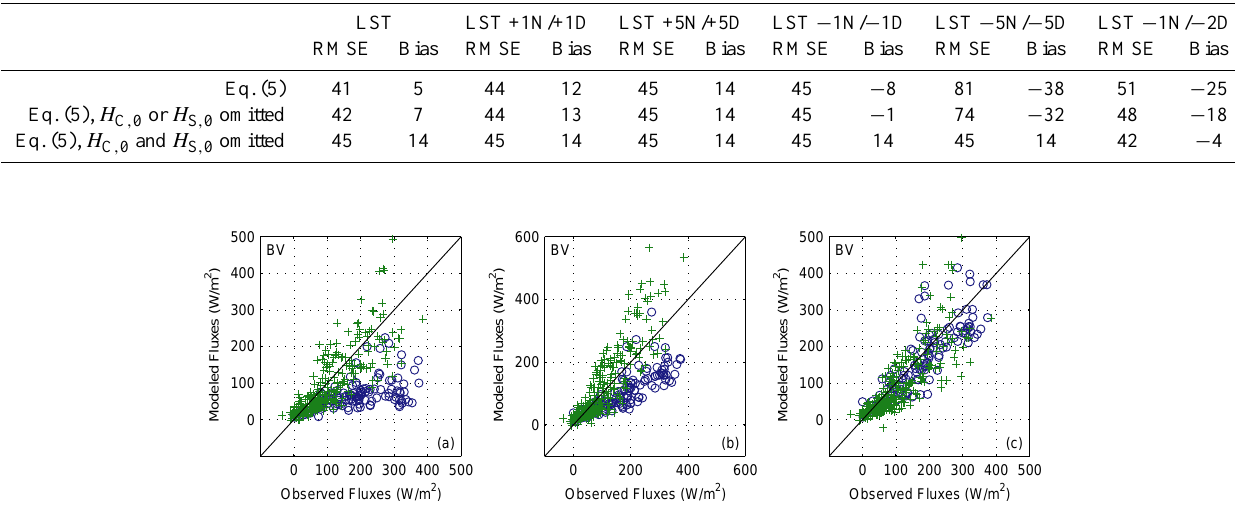
Fig. 5. Instantaneous modelled sensible heat flux during green growing season (crosses) and senescence (circles) with DTD driven by field measured LST with t 0 at one hour past sunrise at the agricultural site (BV) with f g = 1 (a) , f g adjusted based on VI (b) and f g from field observations of LAI (c) . Senescence at BV starts between day of year 216 and 249.